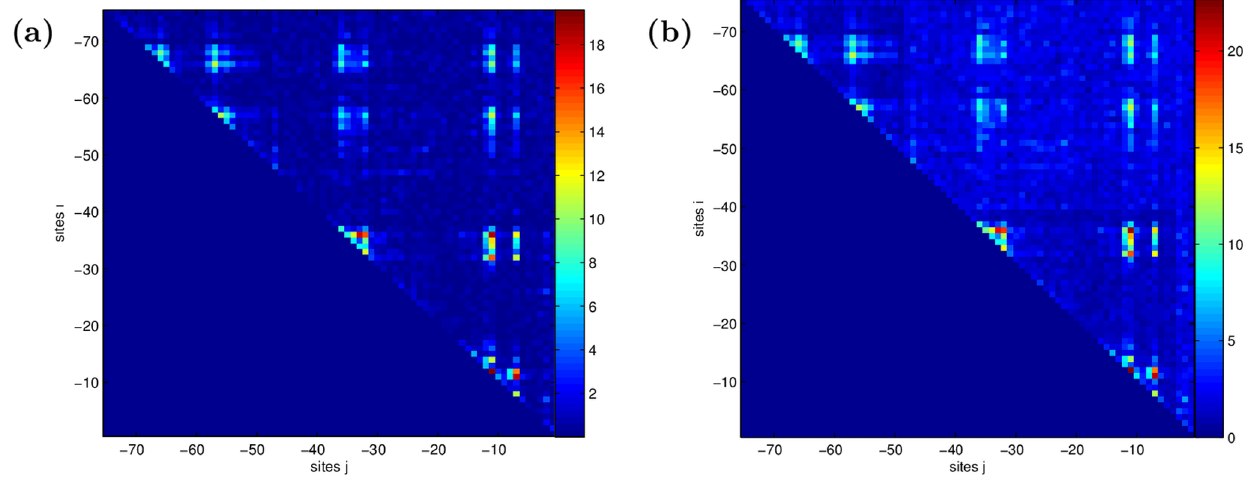
Figure 8. Sensitivity of the epistatic coefficients to the choice of the regularization parameter l . As in Fig. 3, we show the matrices of the sums of the absolute values of the pair interaction coefficients for each pair of sites i , j . a) Coefficients for the model with maximum r 2 b) Coefficients for the full model: l ~ 0 . Notice the same general structure of the coefficients for varying l , including l ~ 0 : 021 in Fig. 3. This indicates stability under changes of the parameter.